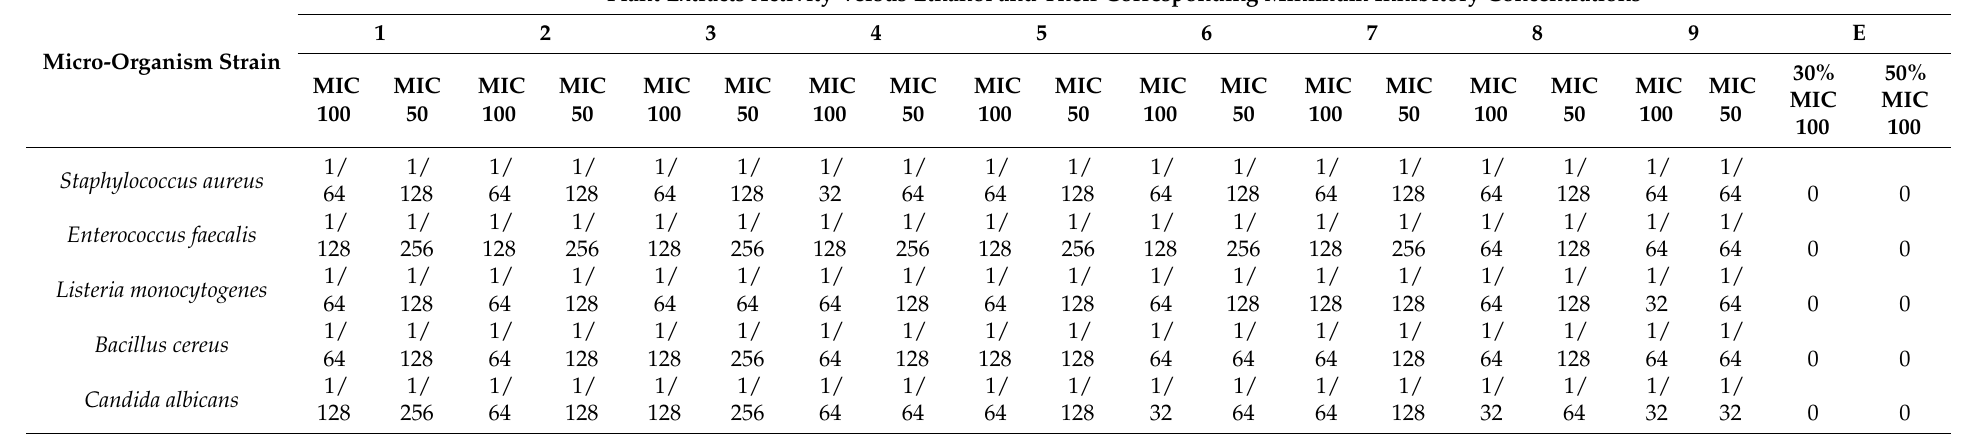
Table 8. The results of the in vitro quantitative evaluation—MIC